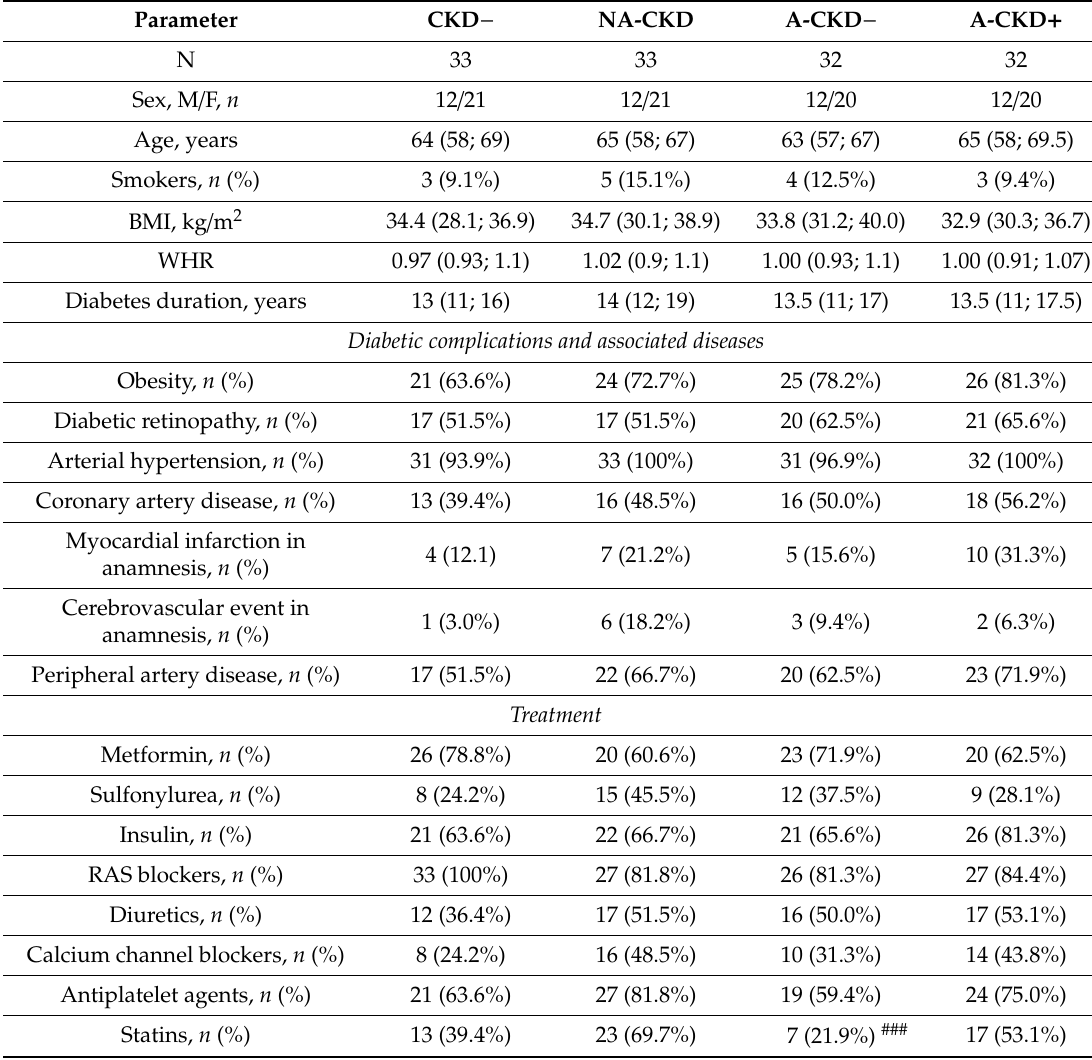
Table 1. Clinical characteristics of T2D patients with albuminuricand non-albumiuric CKD